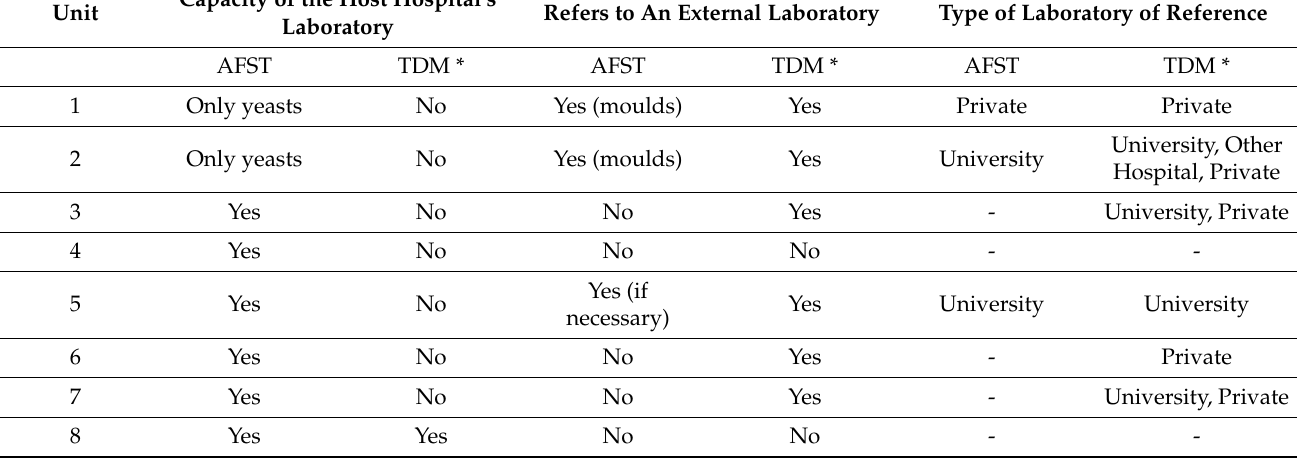
Table 3. Capacity of the host hospitals’ laboratories to perform antifungal susceptibility testing (AFST) and therapeutic drug monitoring (TDM) and information about reference to external laboratories.